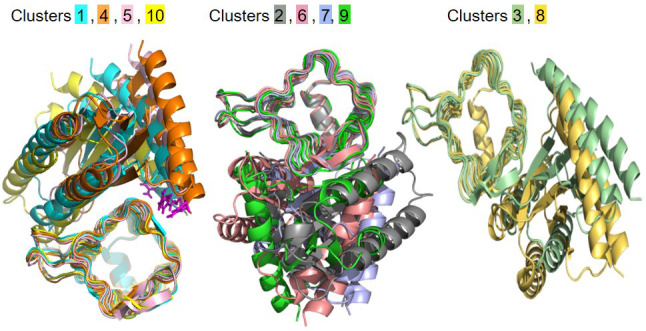
Best models obtained from docking simulations.Three groups composed by equivalent models are presented. Models from each group are superimposed. Each color represents a defined model. R223 residue from the best models in clusters 1, 4, 5, 10 are colored in magenta.